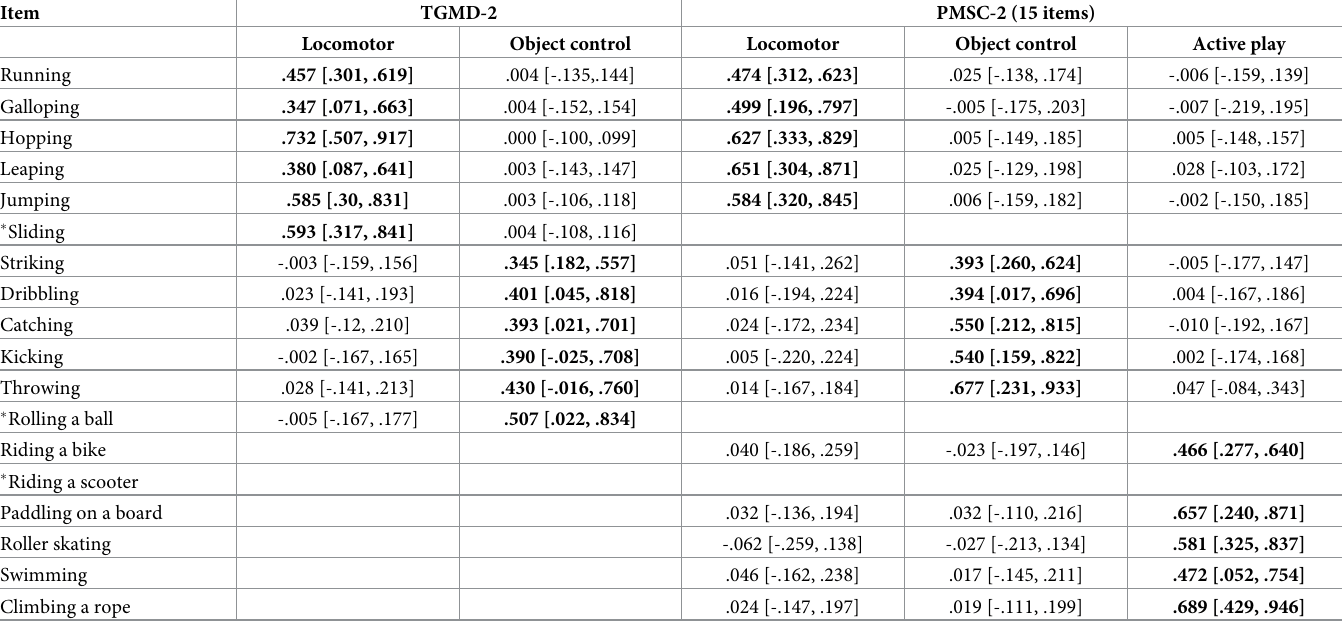
Table 2. BSEM model solutions using informative priors for cross-loadings and residual correlations ( n = 409).